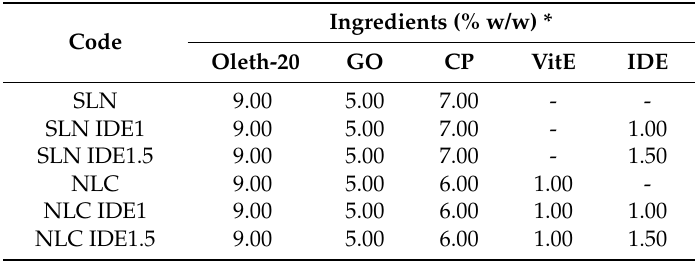
Table 1. Composition of the oil phase of lipid nanoparticles. GO = glyceryl oleate; CP = cetyl palmitate; VitE = tocopheryl acetate, IDE = idebenone, SLN = solid lipid nanoparticles, NLC = nanostructured lipid